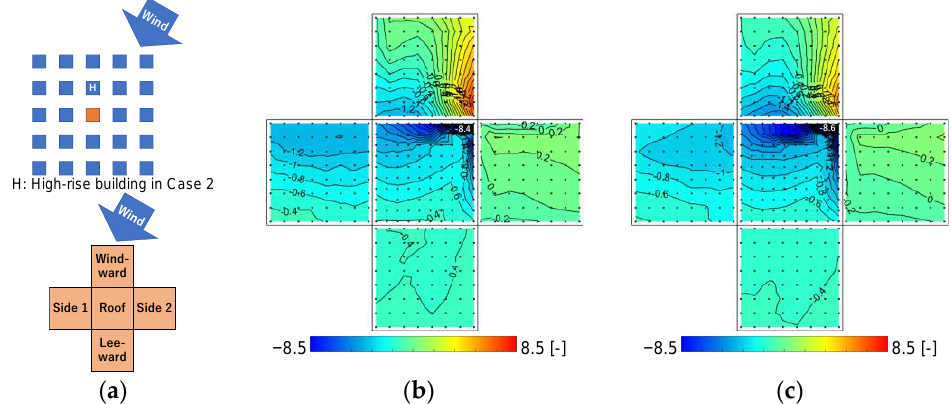
Figure 11. Instantaneous wind pressure coefficient distributions when the maximum and minimum value occurs among all taps in the condition of 0° wind direction; ( a ) building model arrangement and prevailing wind direction; ( b ) distribution when the maximum value of positive 𝑝𝑒𝑎𝑘𝐶 𝑝 occurs among all taps; ( c ) distribution when the minimum value of positive 𝑝𝑒𝑎𝑘𝐶 𝑝 occurs among all taps.